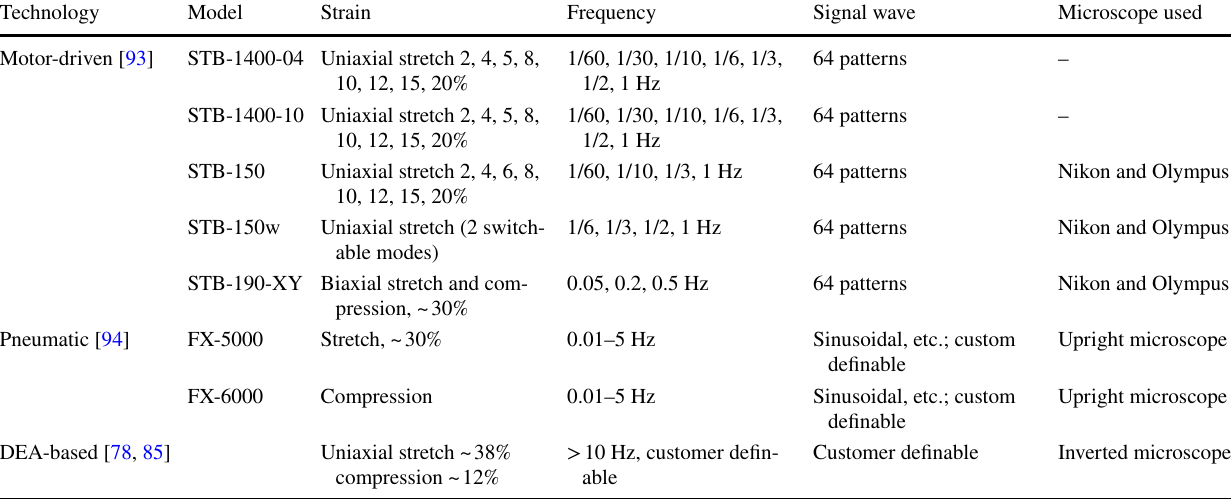
Table 1 Performance parameters of different technologies and models